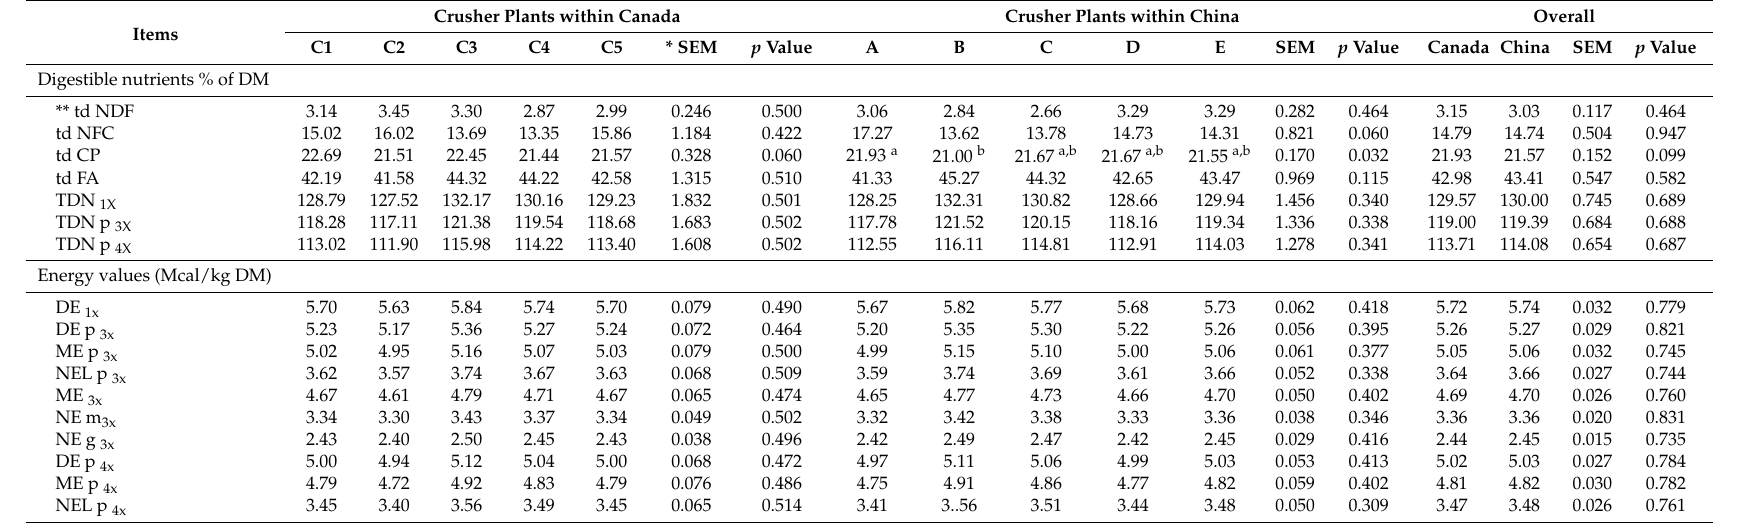
Table 3. Digestible nutrients and bioenergy values of canola seeds: Comparison of crusher plants within Canada and within China as well as between Canada and